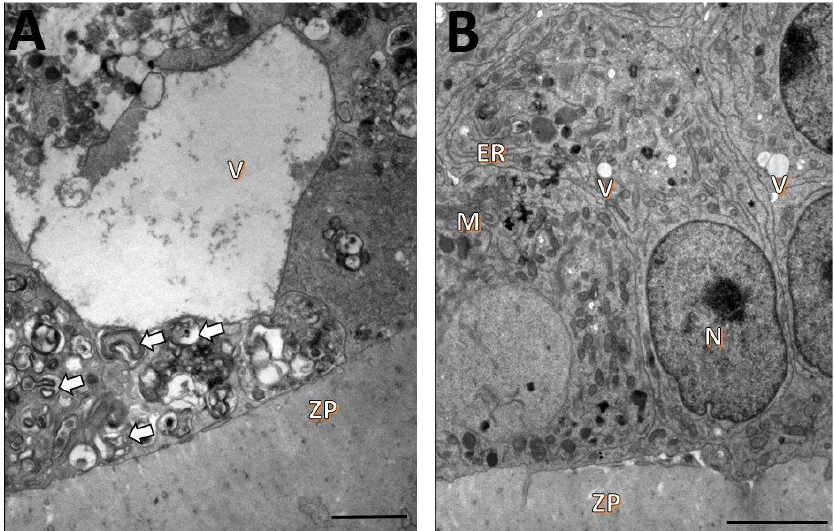
Figure 3. Ultrastructural characteristics of oocytes ( A ) and granulosa cells ( B ) from secondary follicles after 18 days of in vitro culturing in TCM 199 + alone. Mitochondria (M), zona pellucida (ZP), nucleus (N), vacuoles (V), endoplasmic reticulum (ER), degenerating organelles (arrows). Scale bar: 100 µm. The oocytes from follicles cultured in the presence of 1 mM NAC also had intact zo- nae pellucidae in close association with oolemmae, but the ooplasm showed a large num- ber of vacuoles, vesicles, swollen endoplasmic reticula, and damage to the mitochondrial membranes and cristae. Multivesicular bodies and organelles with signs of degeneration were also seen (Figure 4A). The granulosa cells of these follicles were well-preserved, but the mitochondria had reduced numbers of cristae (Figure 4B). Figure 4. Ultrastructural characteristics of oocytes ( A ) and granulosa cells ( B ) from secondary folli- cles after 18 days of in vitro culturing in TCM 199 + supplemented with 1 mM NAC. Mitochondria